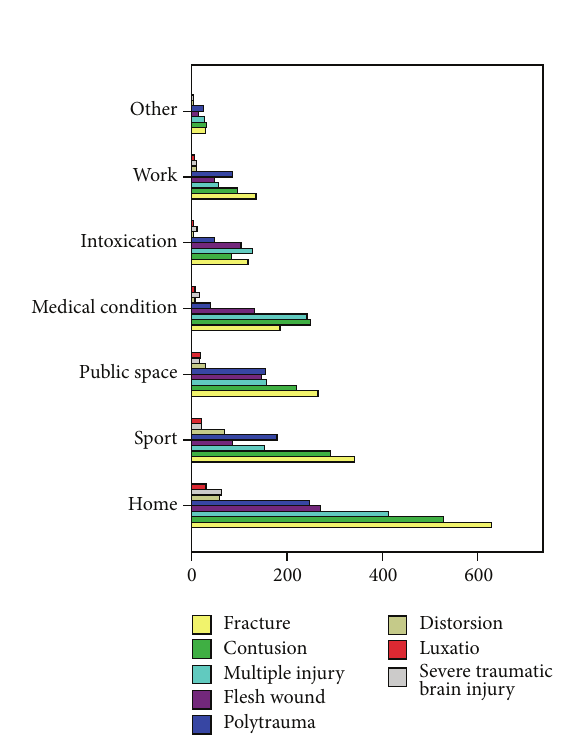
Figure 1: Distribution of injury